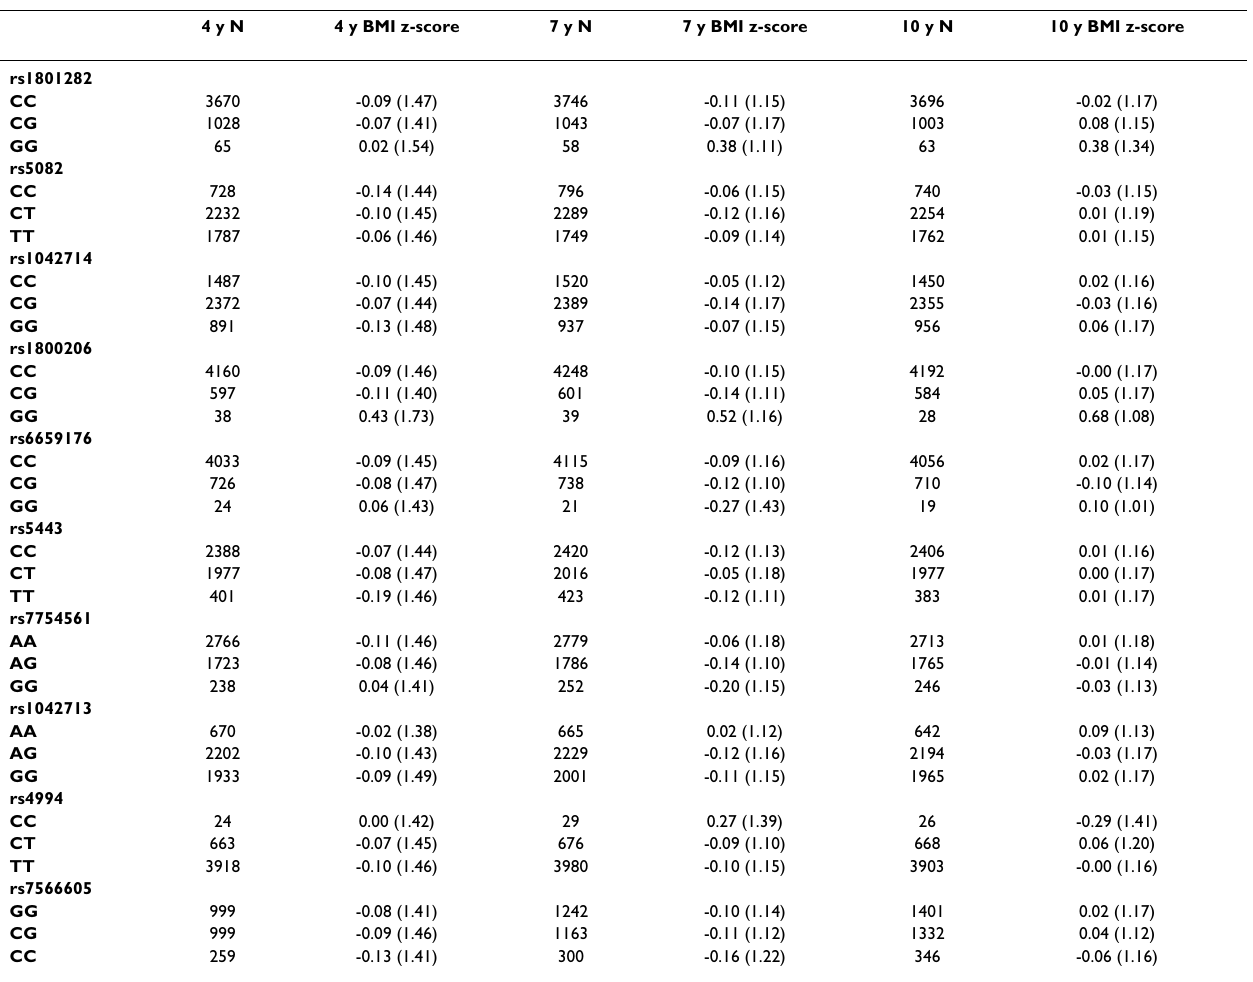
Table 2: BMI z-scores (with standard deviations in parentheses) at 4, 7 and 10 years by genotype 4 y